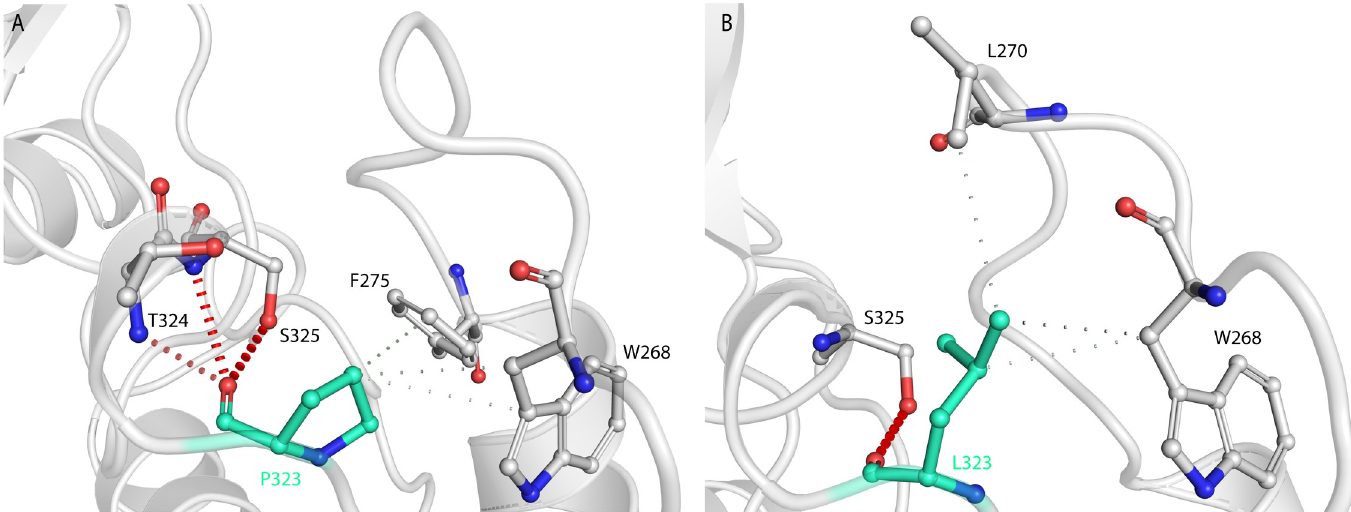
Fig 10. 3D modelling of P323L mutation. (A) Suggested bonding network of P323 where the COO- group might form H-bonds with the backbone NH group of T324 and S325 and the side chain of S325. The grey dashed lines depict the hydrophobic interactions between P323 and W268 and F275. (B) The mutated L323 forms a H-bond with the side chain of S325 and forms a hydrophobic interaction with L270, which is at the curve of the loop making that region more compact.